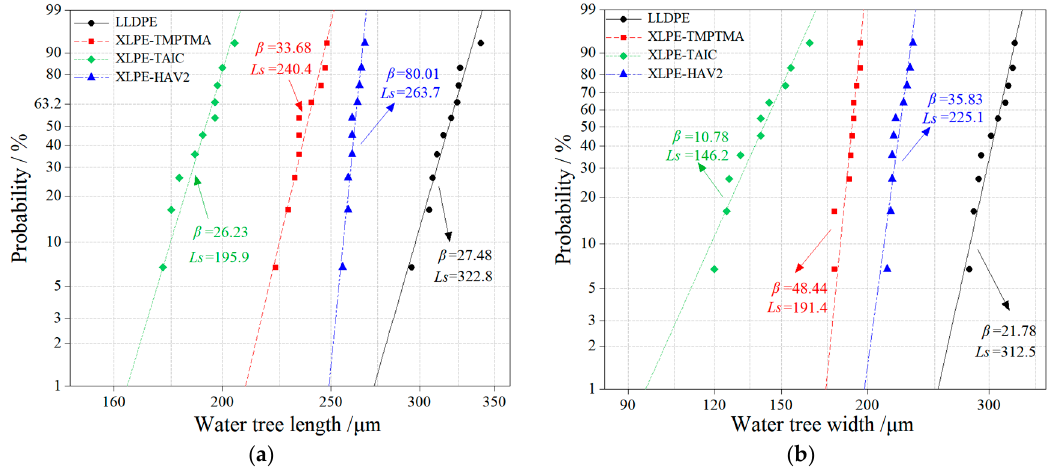
Figure 2. Weibull 2-parameter distributions fitting on the ( a ) length and ( b ) width of water-trees.